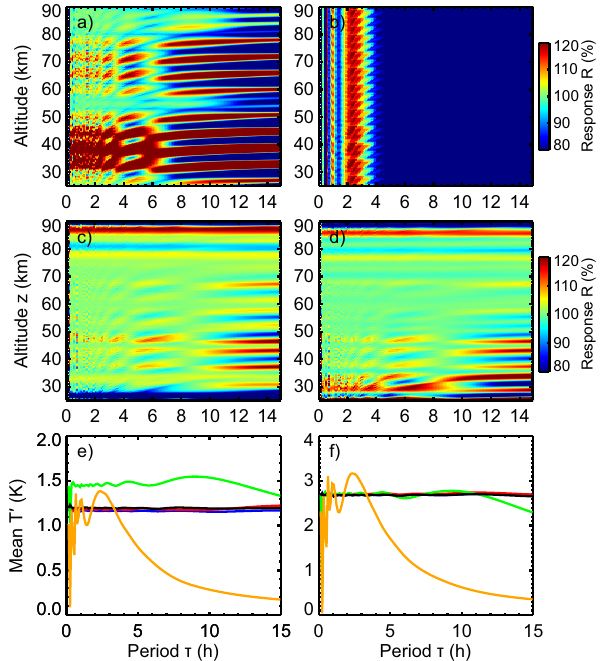
Figure 5. Same as Fig. 3 but with a varying background temperature (see Sect. 3.2 for